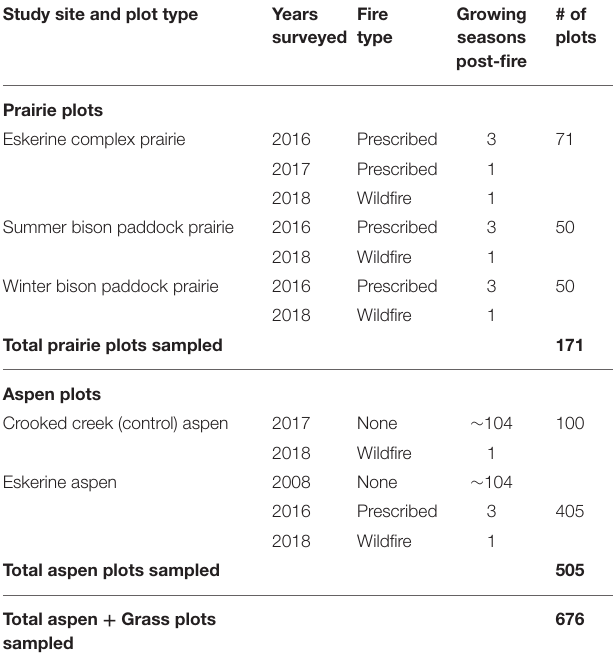
TABLE 1 | Eskerine Complex sampling strategy and sample